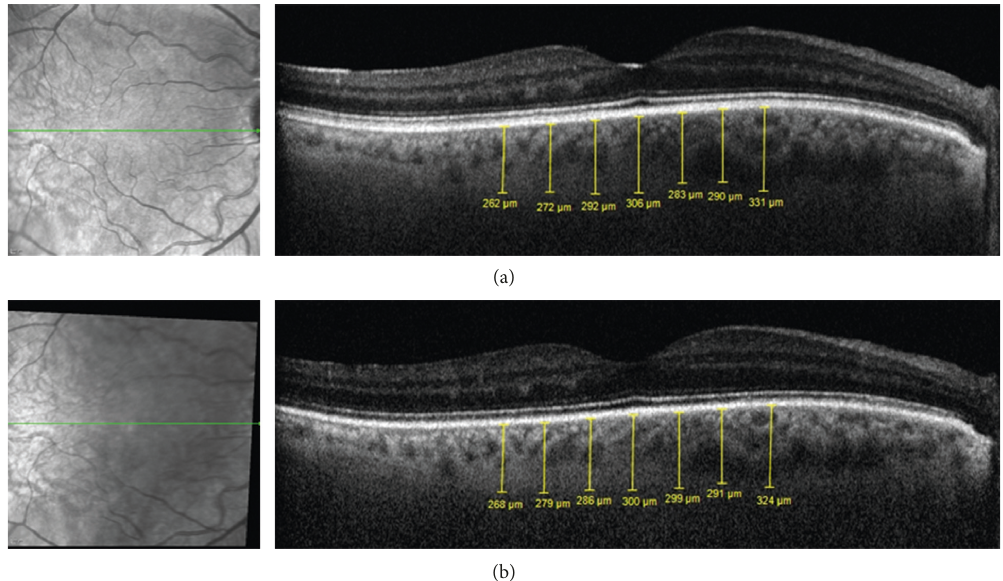
Figure 2: Patient #1: a 61-year-old male, with a past medical history of hypertension, hypercholesterolemia, TIA, and smoking (40 pack- years), presented with right ICA stenosis of 80%. His BCVA at presentation was RE 6/6.5 and LE 6/7.5. Mild nuclear sclerosis was present in both eyes with no pathological findings when performing fundoscopy of both eyes. He underwent an uneventful CEA, and on follow-up, there was no right ICA stenosis at all. EDI SD-OCTimages of the RE, with choroidal thickness measurements (subfoveal; 500 µ m, 1000 µ m, and 1500 µ m nasal and temporal), obtained one day before right CEA (a) and 6 months after CEA (b). TIA: transient ischemic attack; ICA: internal carotid artery; BCVA: best-corrected visual acuity; RE: right eye; LE: left eye; CEA: carotid artery endarterectomy; EDI: enhanced depth imaging; SD-OCT: spectral domain optical coherence